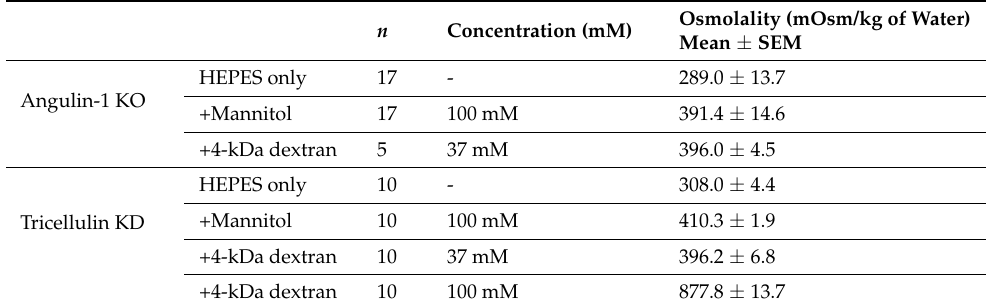
Table 3. Osmolality of the HEPES-buffered solutions using a freezing point depression osmometer. Osmolality (mOsm/kg of Water) n Concentration (mM) Mean ± SEM HEPES only 17 - 289.0 ± Angulin-1 KO